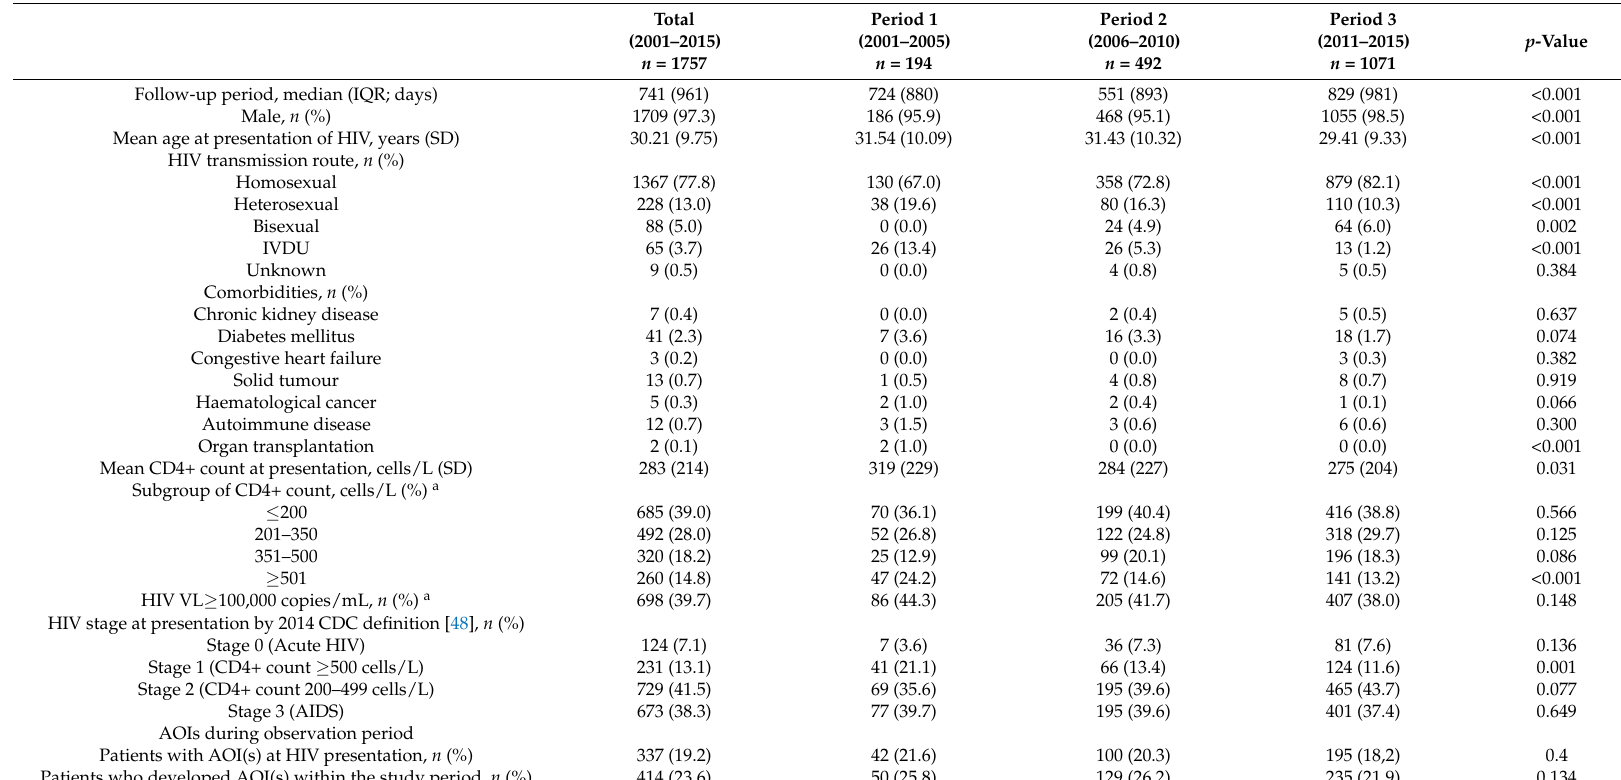
Table 1. Demographic characteristics and HIV-related variables for 1757 patients newly diagnosed with HIV infection from 2001 to